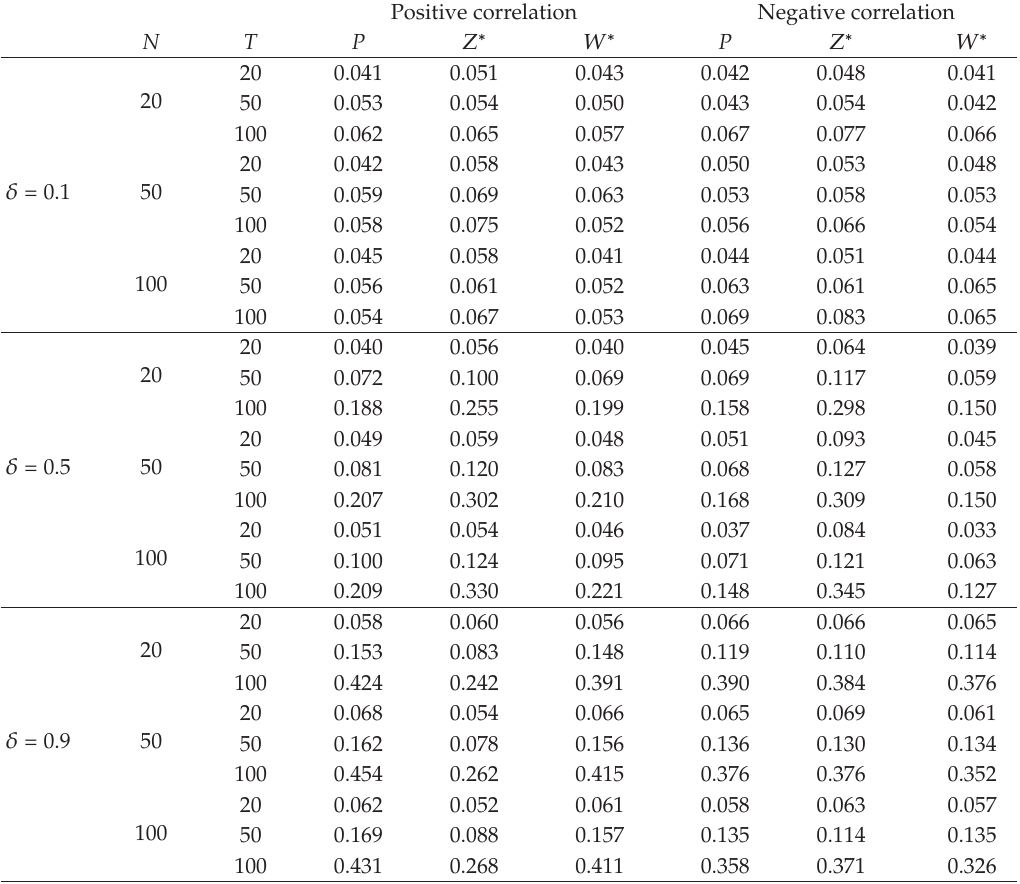
Table 6: Size-adjusted power of panel unit root tests: serial correlation, intercept only, cross-section dependence driven by a common